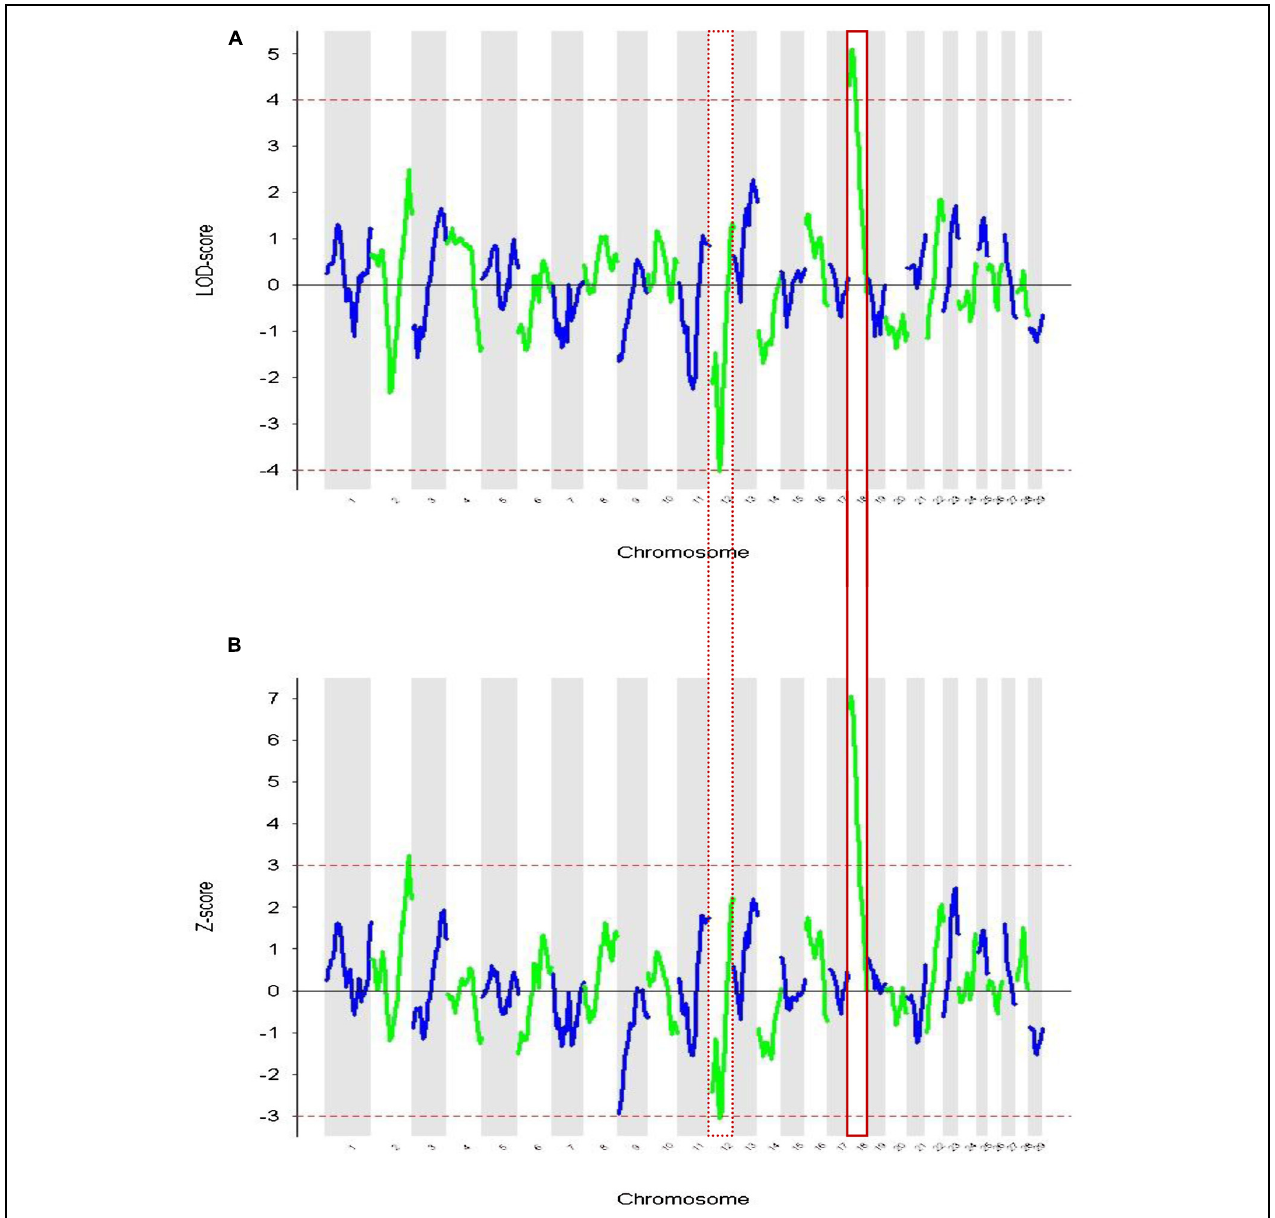
FIGURE 2 | Admixture mapping of coat color phenotype red vs. not-red for each chromosome. (A) Showing LOD score based on differences between local ancestry components vs. genomewide levels. (B) Plotting the Z -scores derived from case-control comparisons. Chromosome 12 and 18 are highlighted because they show significant values in both